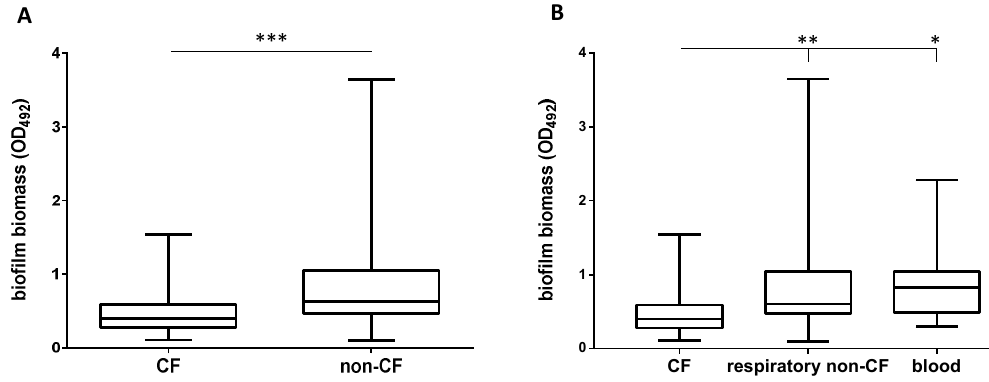
Figure 2. Biofilm formation according to patient and sample types. Biofilm biomass, assessed by spectrophotometric assay after crystal violet assay, was stratified according to ( A ) patients with (CF; n = 40) or without (non-CF; n = 45) cystic fibrosis, and ( B ) sample type (CF, n = 40; respiratory non-CF, n = 29; blood, n = 11). Results are shown as box and whiskers: the ends of the whiskers represent the minima and the maxima of all the data; the box always extends from the 25th to 75th percentiles, while the line in the middle of the box is plotted at the median. Significance level from Mann–Whitney test: * p < 0.05; ** p < 0.01; *** p < 0.001.